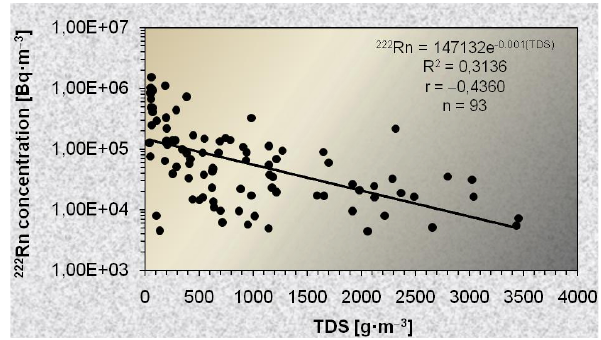
Fig. 3. Correlation between 222 Rn activity concentration in ground- water and the mineralization (Total Dissolved Solids) of the ground- water for the 93 selected intakes and springs of the Sudetes (SW Poland) (according to Przylibski, 2005).